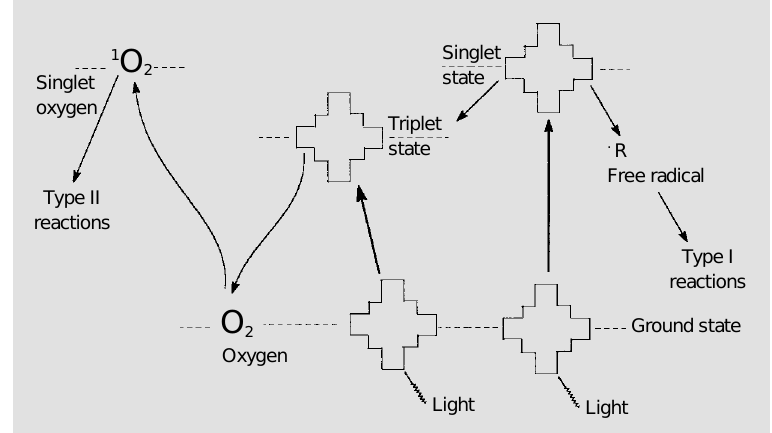
Figure 2 - Energetic transitions in